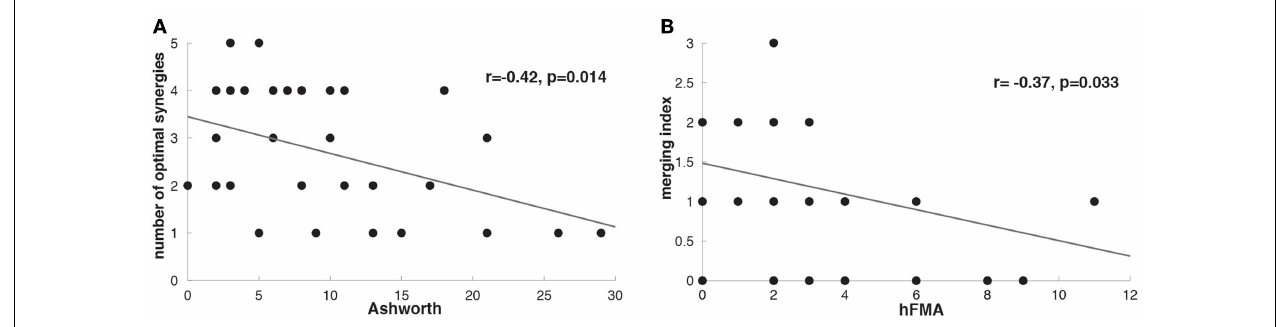
FIGURE 4 | (A) Correlation between Ashworth scale and number of optimal affected synergies ( r =− 0.42, p = 0.014). (B) Correlation between hFMA (hand Fugl-Meyer Assessment scores) and merging index ( r =− 0.37, p =